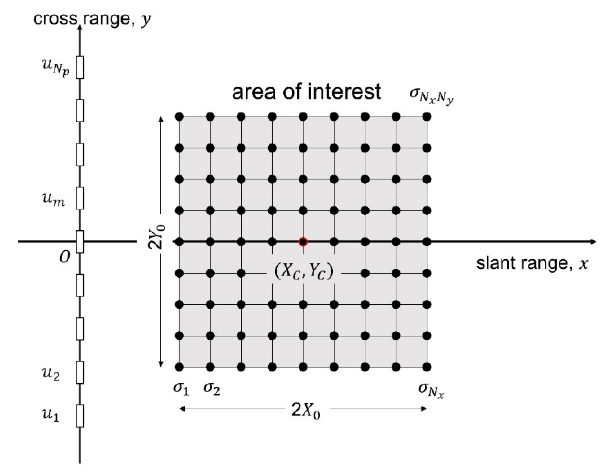
Figure 3. Description for a single sensor sonar operation: u m is the single sensor corresponding to the m -th ping, N p is the total number of pings, σ k is a virtual target, N x is the number of the grid in the x direction, N y is the number of the grid in the y direction, ( X c , Y c ) is the center point of the area of interest, X 0 is the half-size of the area of interest in the x direction, Y 0 is the half-size of the area of interest in the 𝑦 direction.